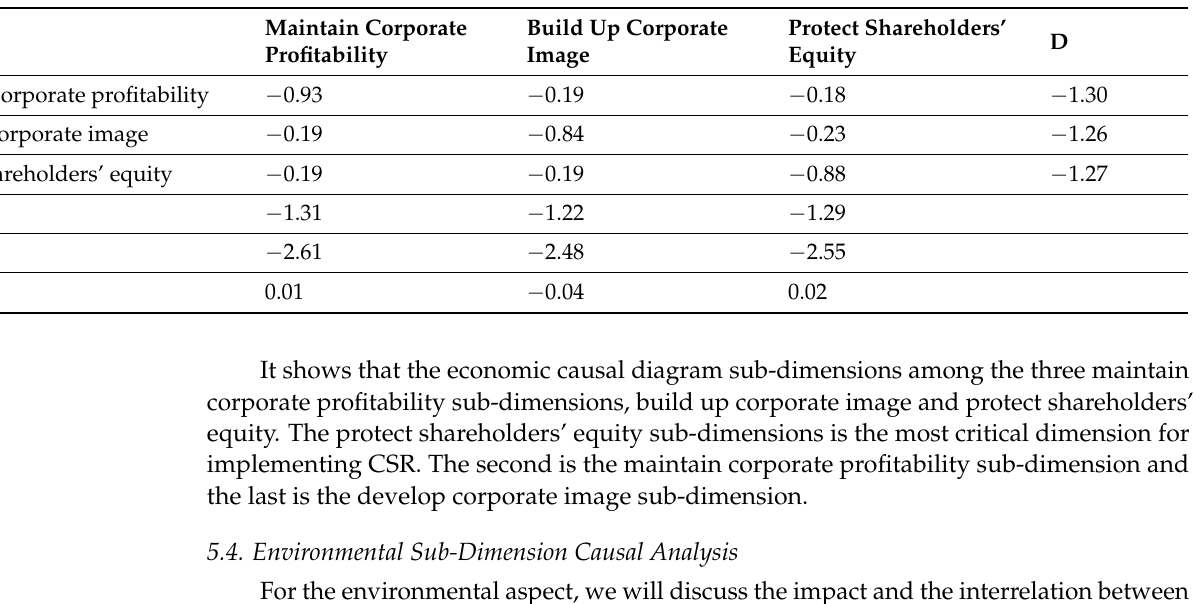
Table 3. The economics sub-dimension impact degree.